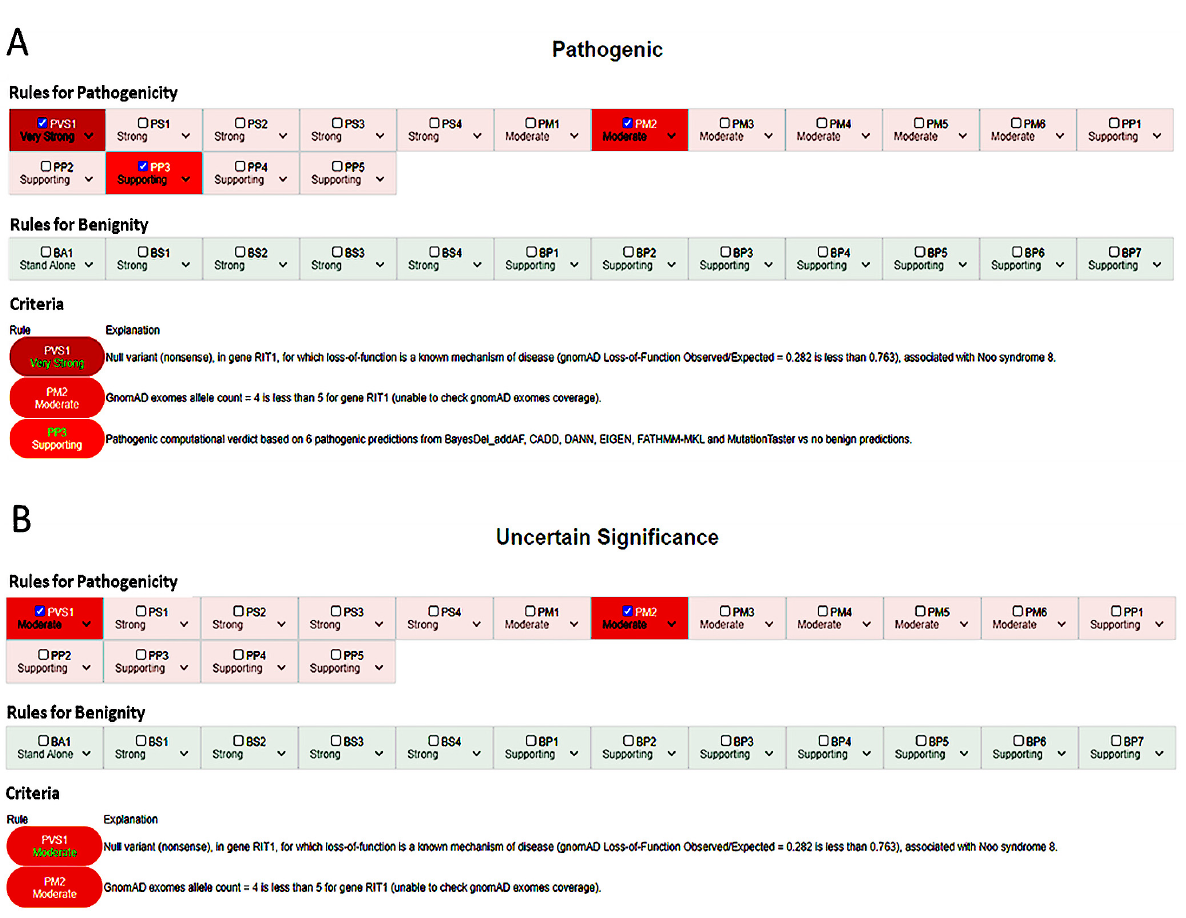
Figure 1. ( A ) Automatic classification for the c.650C>G p.(Ser217*) variant in the RIT1 gene using VarSome Stable-API v.9.4.6. ( B ) Adjusted manual interpretation with PVS1_Moderate and PP3 disabled according to ACGS 2019 recommendations